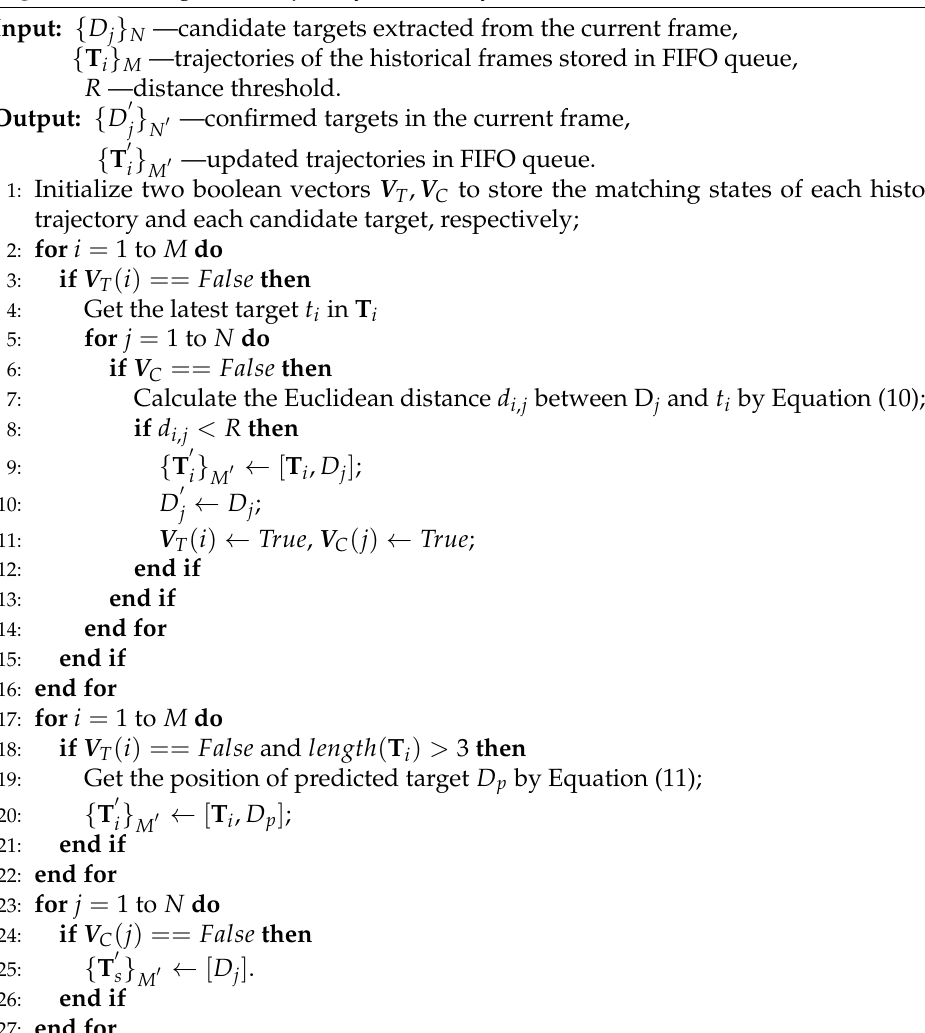
Algorithm 1 Long-term Trajectory Continuity (LTC)